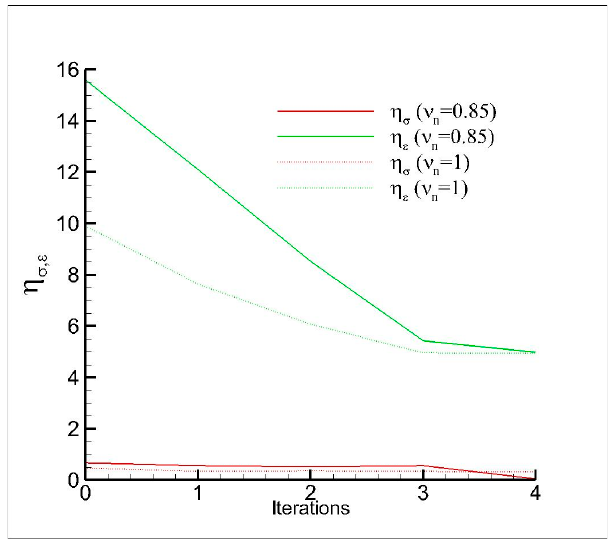
Figure 15. Global/Local performance with respect to the Reference Model—conformal mesh and Figure 15. Global / Local performance with respect to the Reference Model—conformal mesh and optimal non–conformal mesh—Local Model 2. optimal non–conformal mesh—Local Model